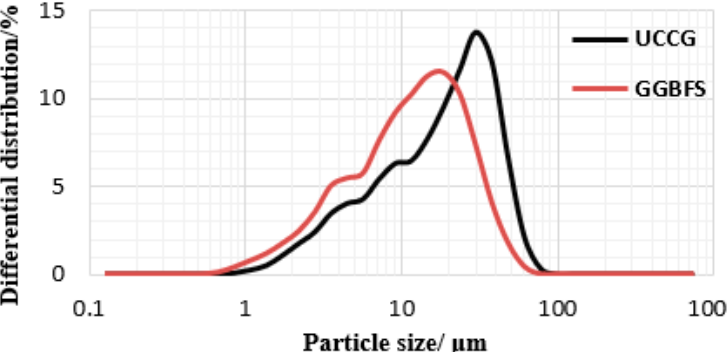
Figure 15. Raw materials. ( a ) UCCG ( b ) GGBFS powder.